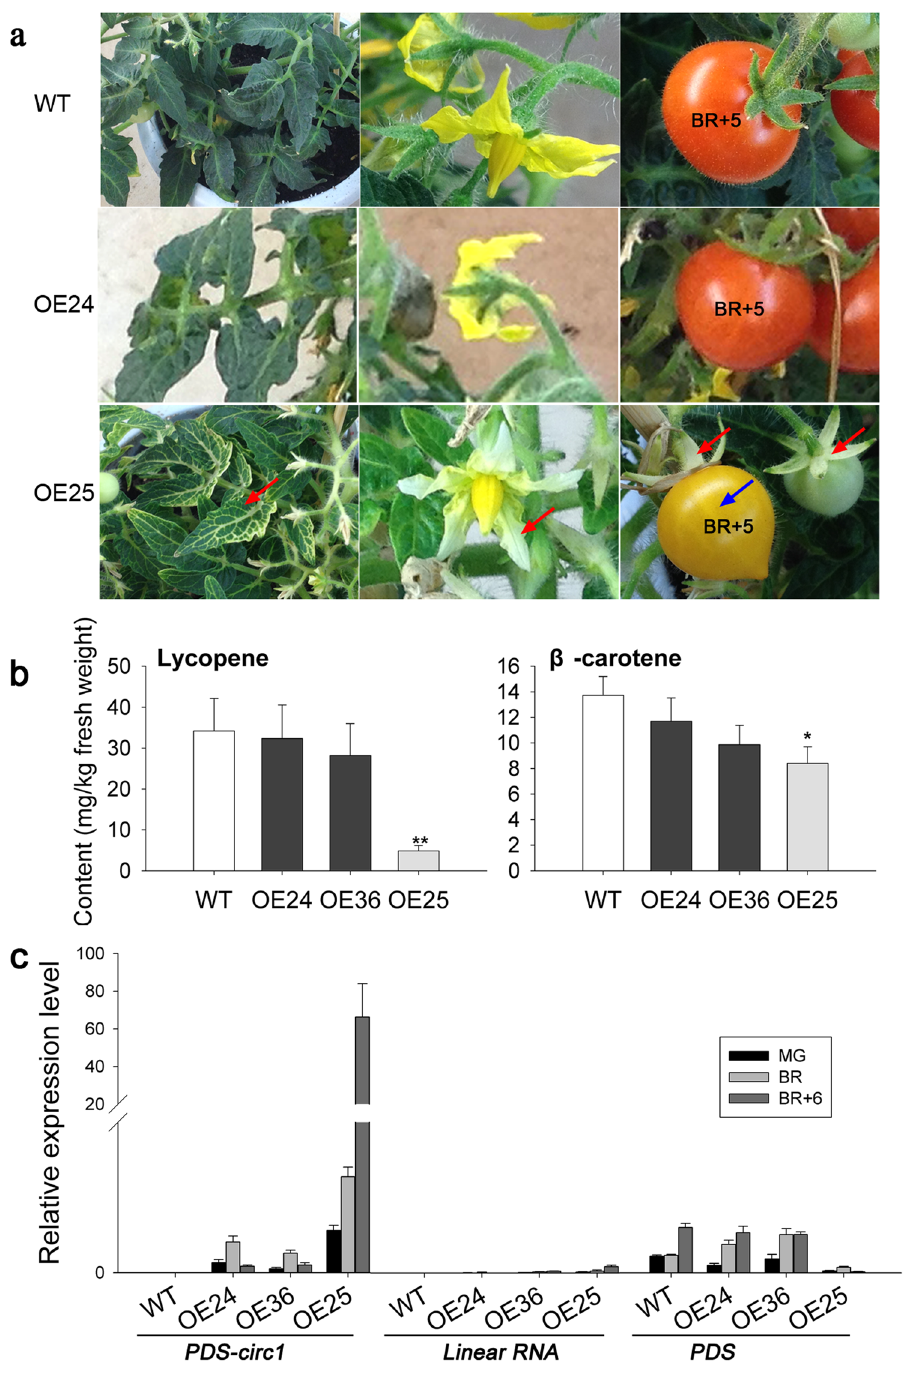
Figure 5. Overexpression of PDS-circ1 in microTom. ( a ) Leaves, flowers and fruits of different PDS-circ1 overexpression lines and the control (WT), red arrows indicate photo-bleaching of leaves, petals, and sepals, blue arrow indicates yellow fruit. ( b ) Lycopene and β -carotene contents in transgenic tomato fruits at breaker + 10 stage. White, black and gray bars stand for control, transgenic lines with red fruits and yellow fruits respectively. The data with error bars are expressed as mean ± SEM (n = 5), asterisks indicate statistically significant difference (with respect to control; * p value < 0.05; ** p value < 0.01; two-way ANOVA followed by LSD test). ( c ) Expression profile of PDS-circ1, linear RNAs generated by the overexpression vector, and PDS gene in transgenic tomato fruits at different ripening stages. The data were normalized to Actin and presented as means ± SD (n = 5). OE24-OE36 stand for different transgenic